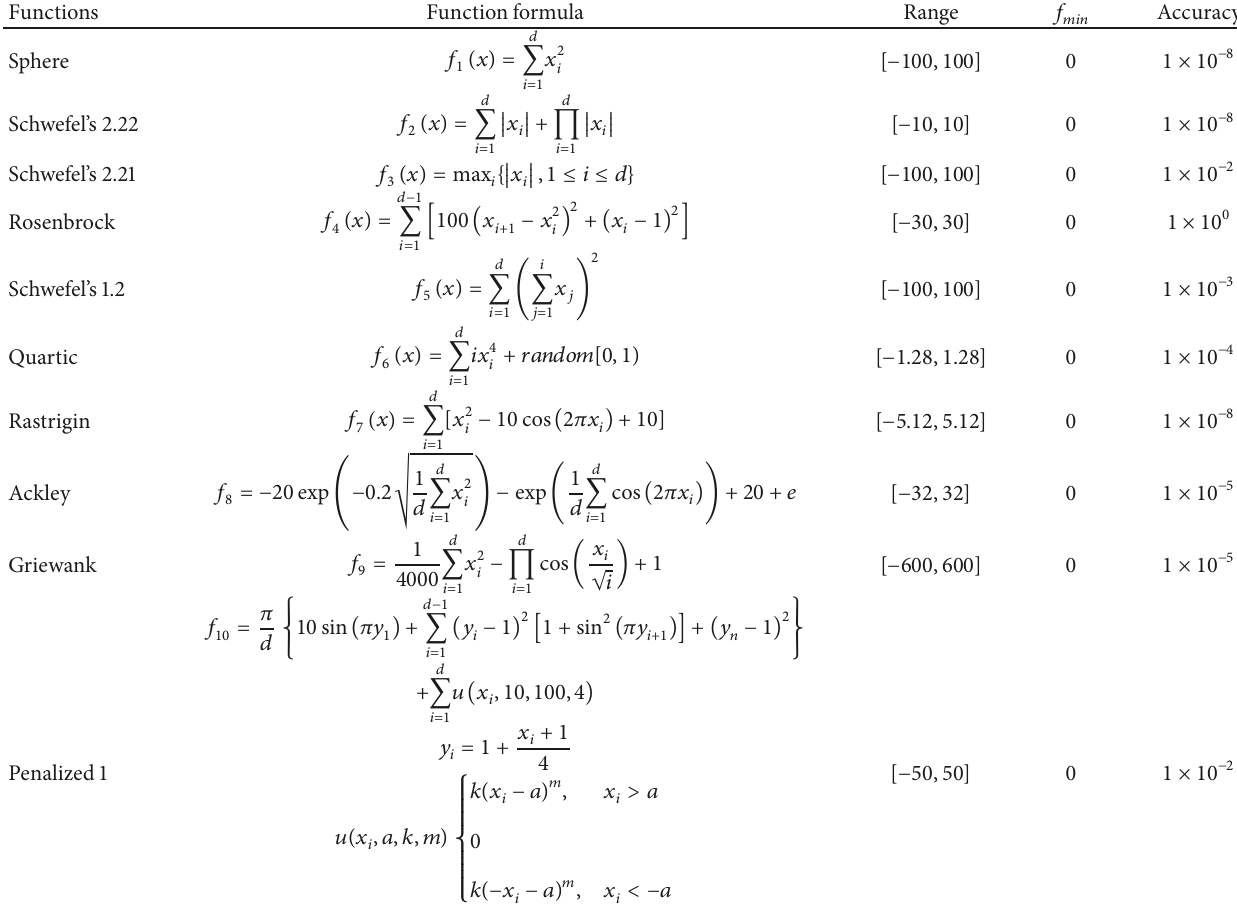
Table 2: 10 high-dimensional benchmark